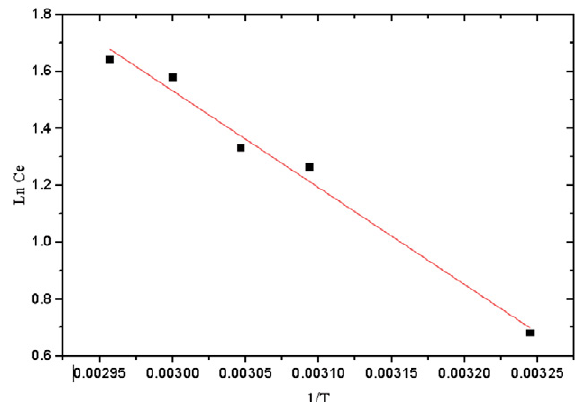
Figure 16. Ln Ce vs temperature for calculation isosteric heat of adsorption Table 3. Thermodynamic parameters of adsorption Thermodynamic parameter ΔH° kJ mol